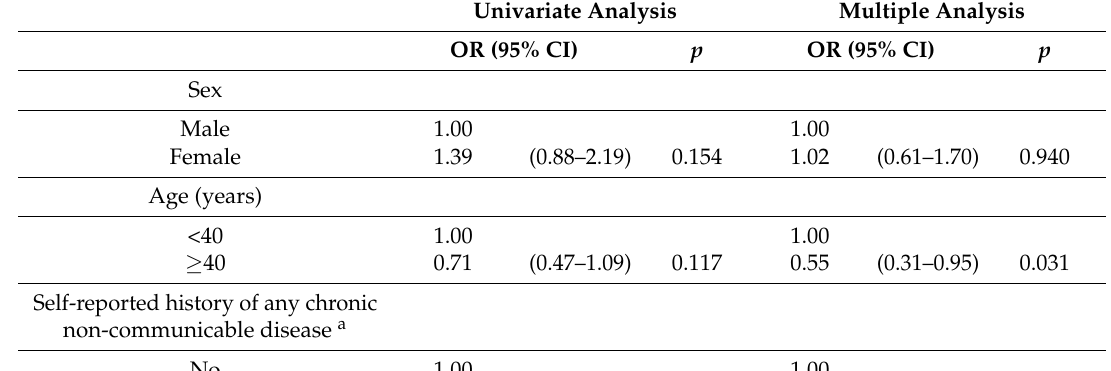
Table 2. Markers associated with the risk of depressive symptoms (Patient Health Questionnaire-2 score ≥ 3) during the acute chikungunya virus infection, Mexico 2015. Univariate Analysis Multiple